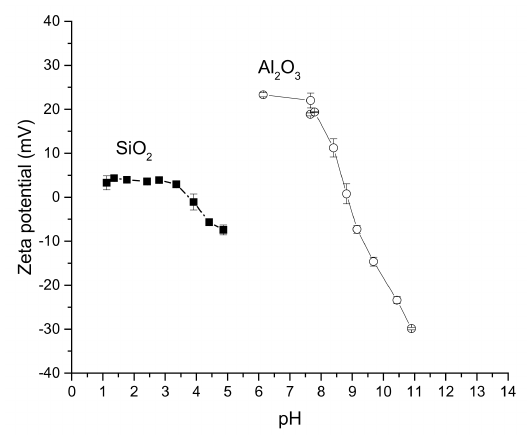
Figure 5. Zeta potential as a function of pH for Al 2 O 3 (La Roche Versal alumina GL25) and for SiO 2 (Merck silica gel Si-60). Conditions: 2 mg/mL, 25 ◦